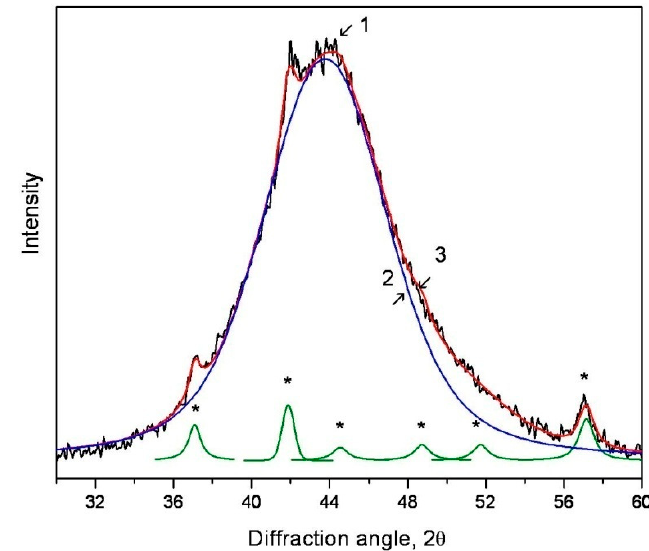
Figure 7. Result of the expansion of the X-ray diffraction pattern of the sample after deformation at 5 rotations: 1(black)–experimental spectrum, 2 (red)–summation curve, 3 (blue)–diffuse halo from the amorphous phase (reflections corresponding to the crystalline phase (green) are marked with asterisks).